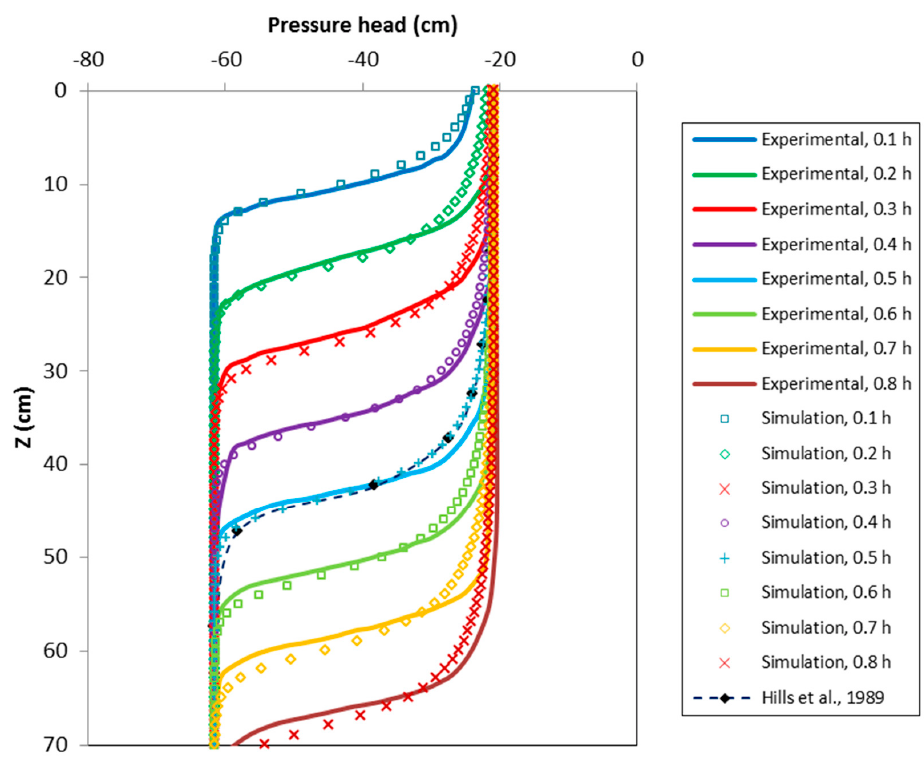
Figure 4. Comparison of model results: The pressure head profiles (Haverkamp et al. [27] & Hills et al.